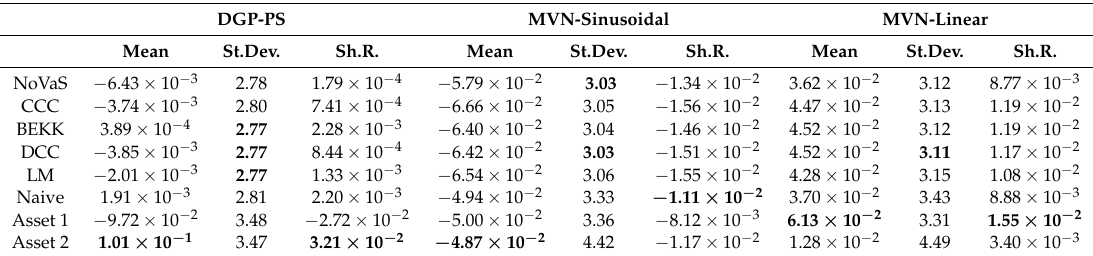
Table 4. Mean, standard deviation and sharpe ratio of portfolio returns, where the hedge ratio is based on the methods in the left column. NoVaS stands for the NoVaS method that for the specific dataset had the most convincing results when capturing the correlation.